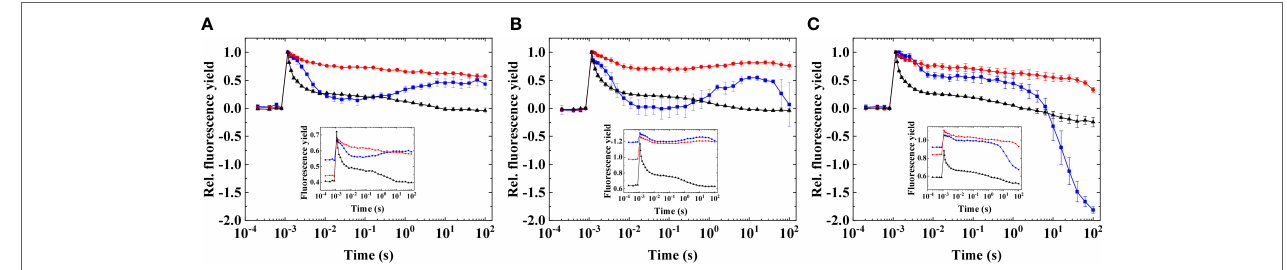
FIGURE 6 | Flash-induced fluorescence relaxation in three different species of Symbiodiniaceae in heat-treated cells in combination with microaerobic conditions. (A) Fugacium kawagutii (CS156), (B) Symbiodinium tridacnidorum (2465), and (C) Symbiodinium microadriaticum (2467), including control (black), heated (at 38°C, red), and heated + microaerobic (blue). Main figures: normalized fluorescence (mean values of three biological replicates ± S.D.). Insets: original data (representative traces). The fluorescence traces were double normalized (F 0 to 0 and F m to 1) to achieve the same initial amplitudes. Insets show original traces without